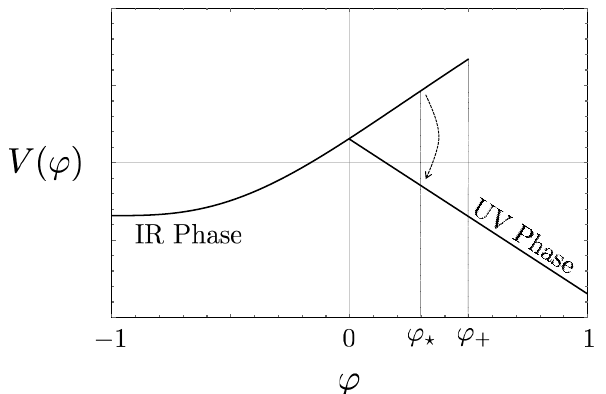
Figure 6 . A sketch of the scalar potential V ( ϕ, h h i ) with the two branches corresponding to the IR ( h h i = v ) and UV ( h h i ∼ M/g inflation, the supercooled IR phase terminates at ϕ UV